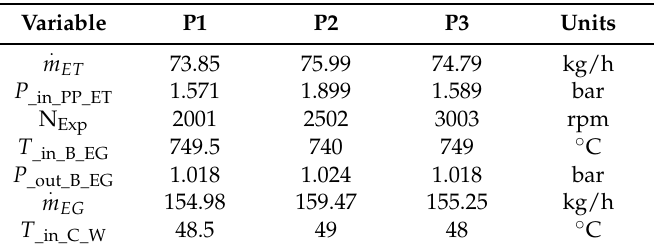
Table 5. Inputs of the ORC model.